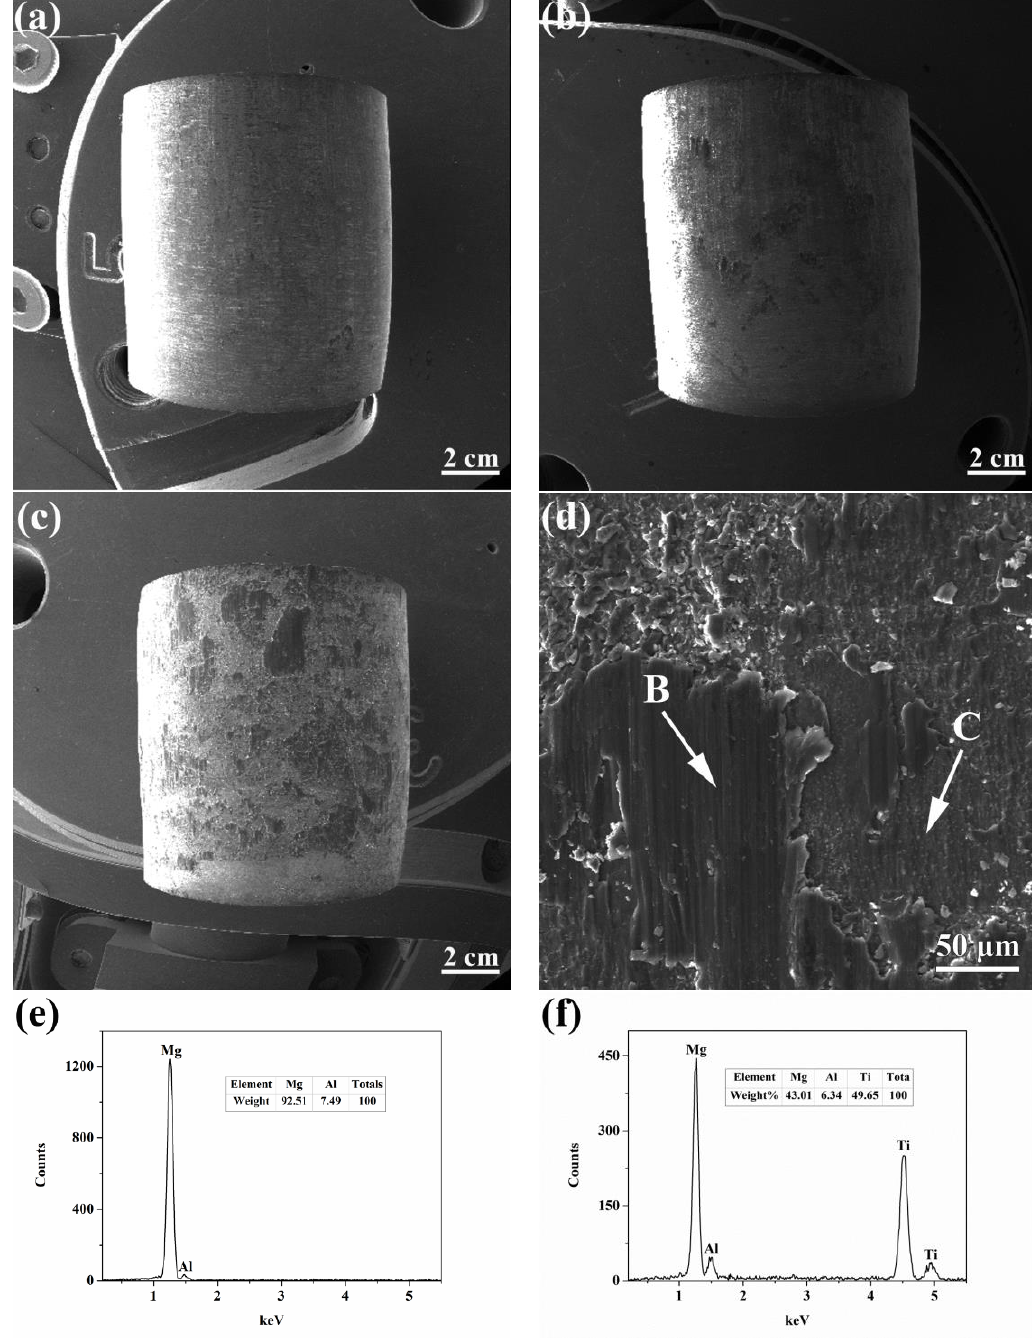
Figure 8. BSE fractographs of Ti rod for ( a ) 0 min, ( b ) 30 min, ( c ) 60 min; ( d ) magnified image of the Ti rod for 60 min; ( e ) EDS of the point B; ( f ) EDS of the point C.